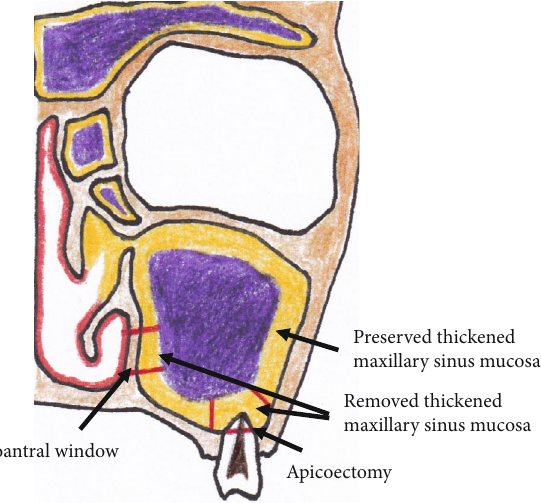
Figure 2: Schematic demonstration of CMSM. Apicoectomy was performed. A large nasoantral window in the inferior nasal meatus was prepared. The remainder of the thickened MSM was preserved.